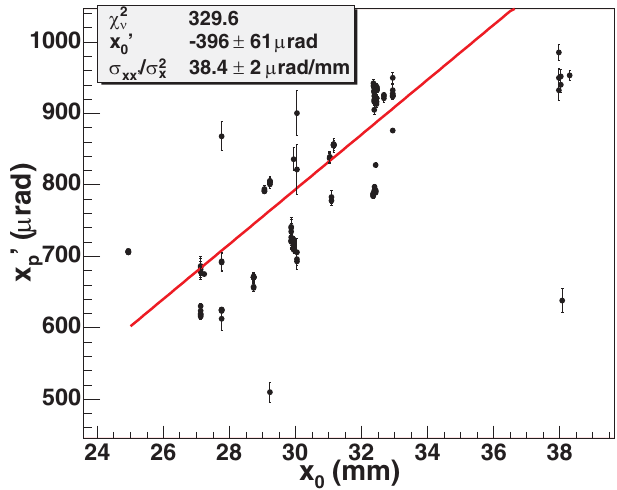
FIG. 11. (Color) Graph of the channeling dip vs crystal location (cid:4) 1 m . All points are included in the for (cid:8) (cid:10) PHENIX